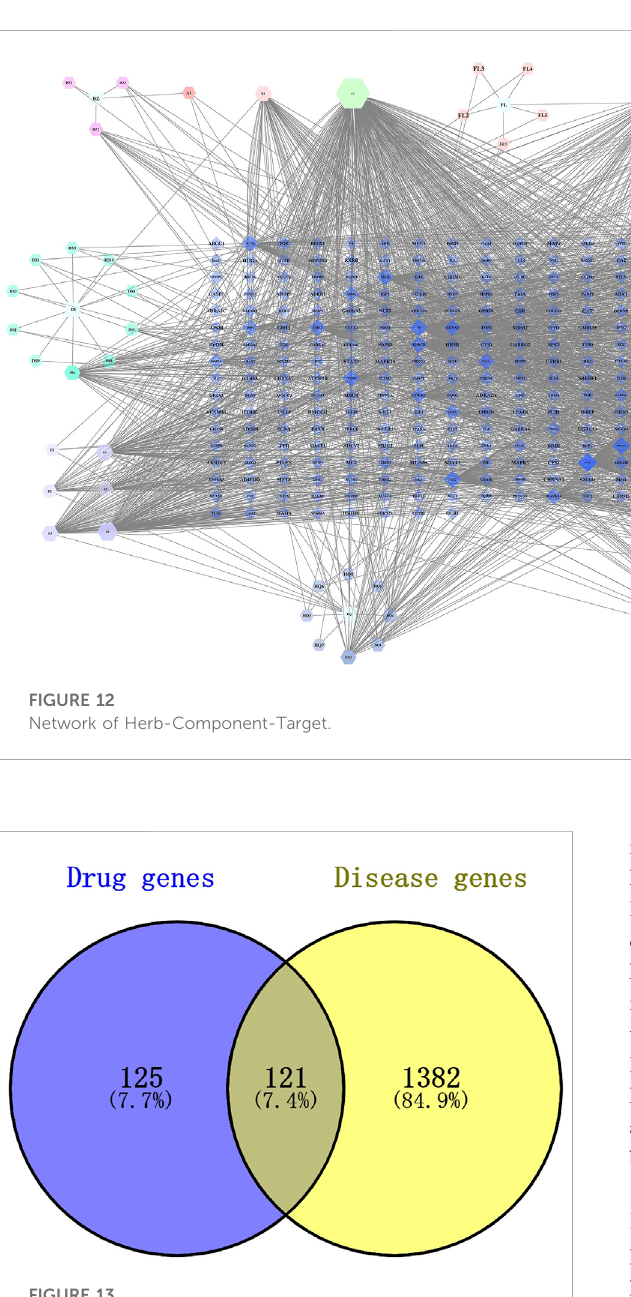
FIGURE 13 The number of intersection targets of effective herbs and